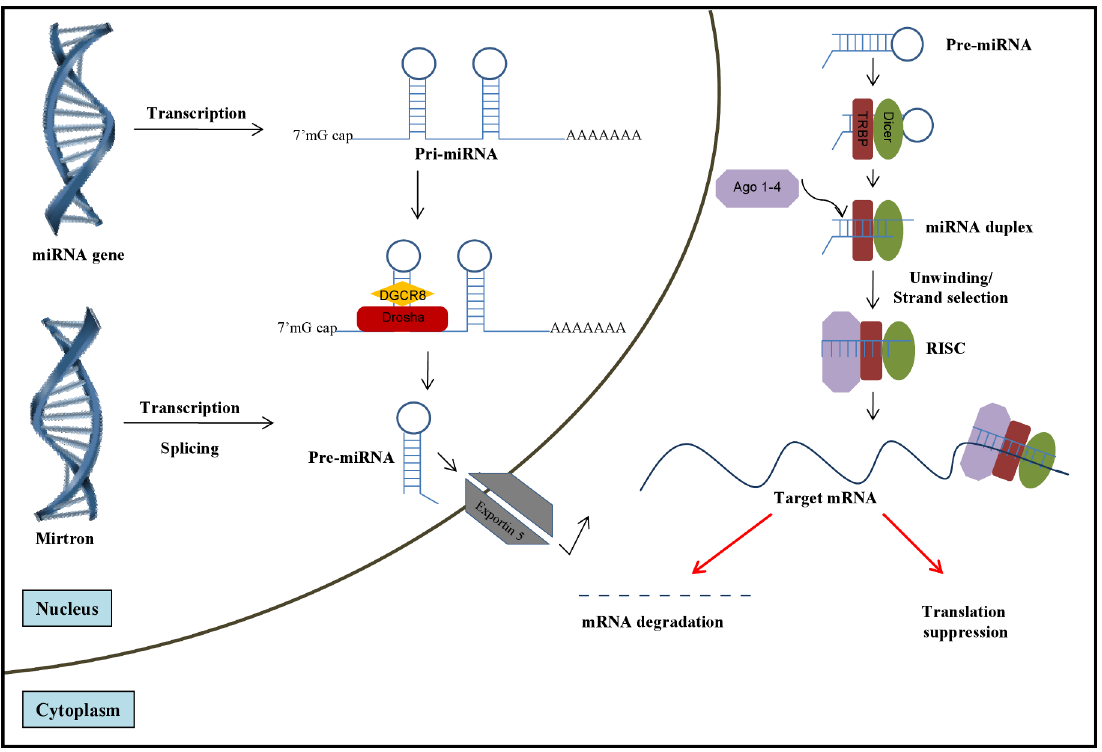
Figure 1. Biogenetic pathway of cellular miRNAs. MicroRNAs are transcribed from either independent miRNA genes as primary miRNAs (pri-miRNAs) or introns of protein coding genes (mirtrons). The pri-miRNA is cleaved by the Rnase III enzyme Drosha and its binding partner DGCR8 to a hairpin shaped precursor miRNA (pre-miRNA), which is recognized and exported by the nuclear export receptor Exportin 5 and Ran-GTP into the cytoplasm. Once in the cytoplasm, the pre-miRNA is processed by Dicer into a miRNA duplex which is then loaded onto Argonaute proteins to form a RNA-induced silencing complex (RISC). The fate of the target mRNA recognized by the RISC complex depends on the degree of complementarity between the miRNA and its cognate sequence on the mRNA. Typically, identical sequence match between the miRNA and its target site within the 3’ UTR of the transcript leads to mRNA cleavage and subsequent degradation while incomplete complementarity often results in suppression of